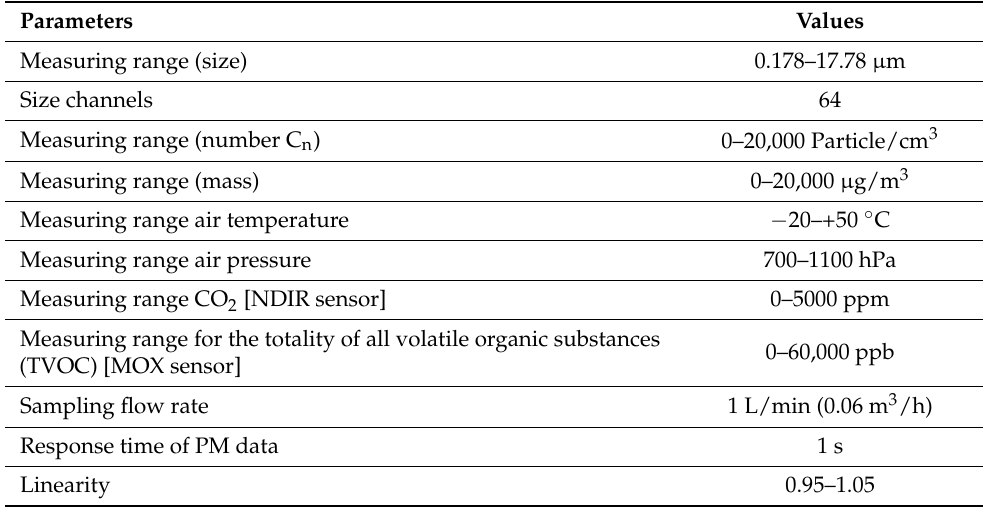
Table A2. Characteristics of the AQ Guard from PALAS according to the manufacturer’s